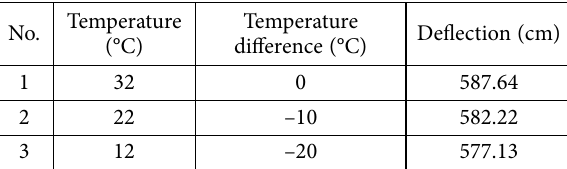
Table 6. Analysis results of deflection with different temperatures